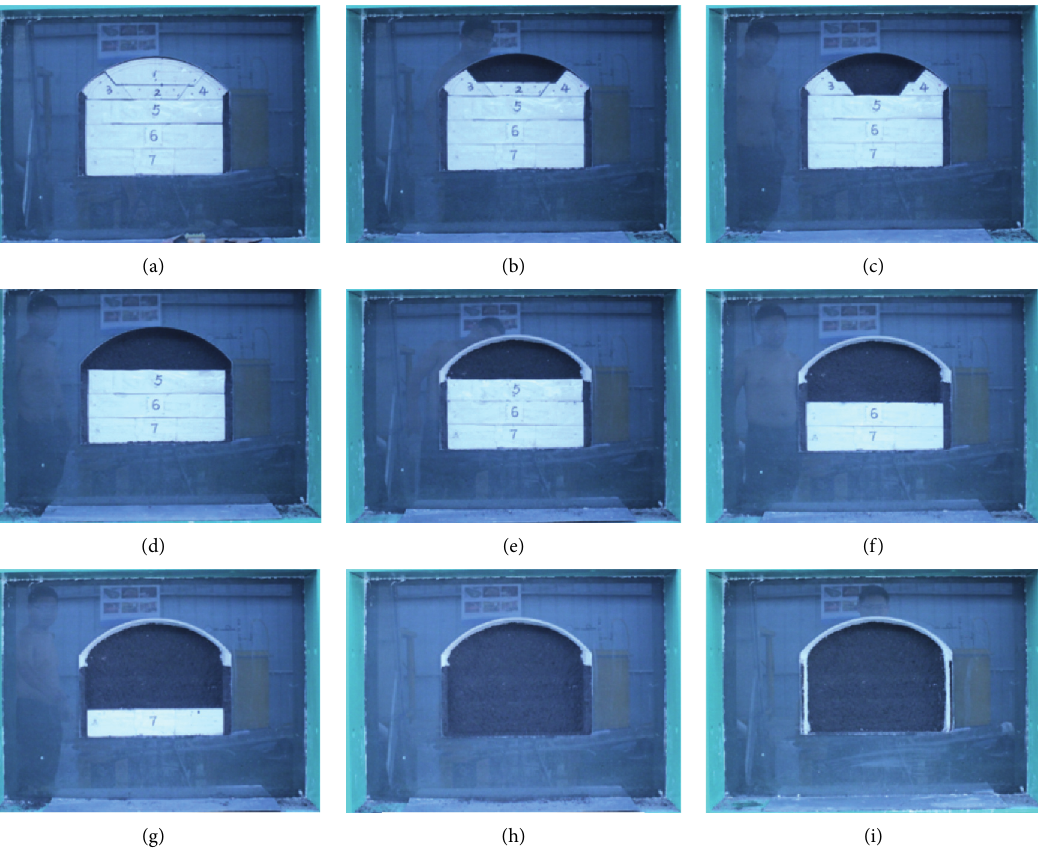
Figure 13: Excavation sequence sketch of the primary support arch-cover method. (a) Initial excavation face. (b) Area 1 excavated. (c) Area 2 excavated. (d) Area 3 and 4 excavated. (e) Primary support conducted. (f) Area 5 excavated. (g) Area 6 excavated. (h) Area 6 excavated. (i) Side-wall primary